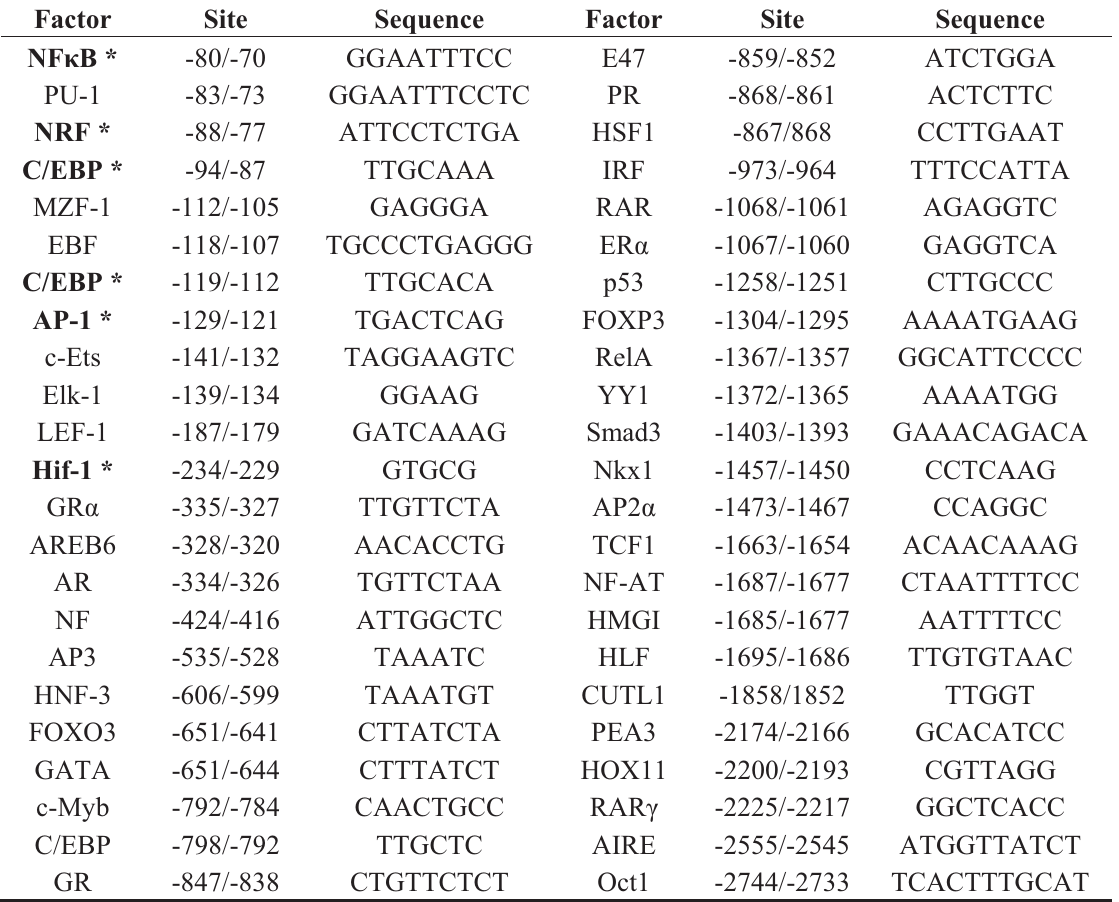
Table 5. List of putative transcription factor binding sites in human CXCL8 promoter.